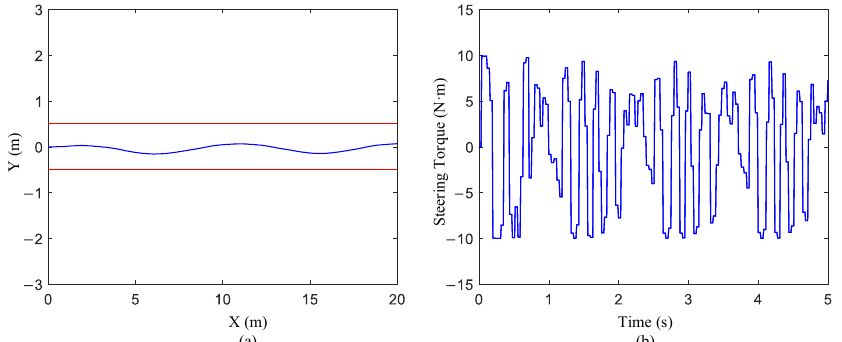
Figure 9. Results of STTW robot driving on straight-line terrain: ( a ) front wheel trajectory; ( b ) steer- ing torque.